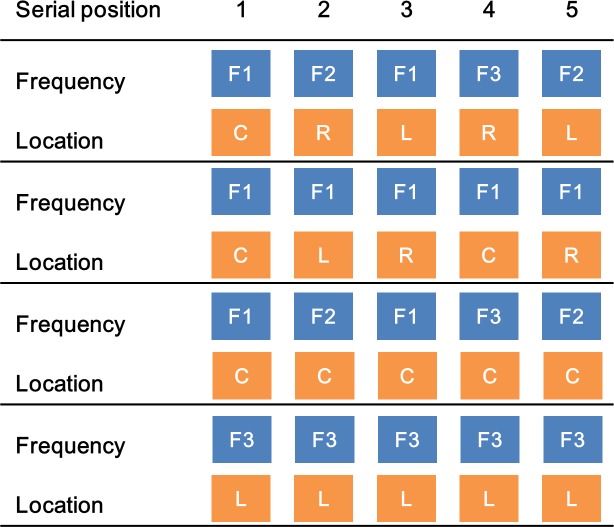
Schematic representation of the pitch/location stimulus sequence combination for working memory tasks.Frequency symbols F1, F2, F3 represent three different frequencies; location symbols C, R, L indicate sound lateralized to positions central, right, and left of participant’s head. Stimulus sequences from the top to bottom illustrate the four combinations of pitch and location constant or varied conditions.